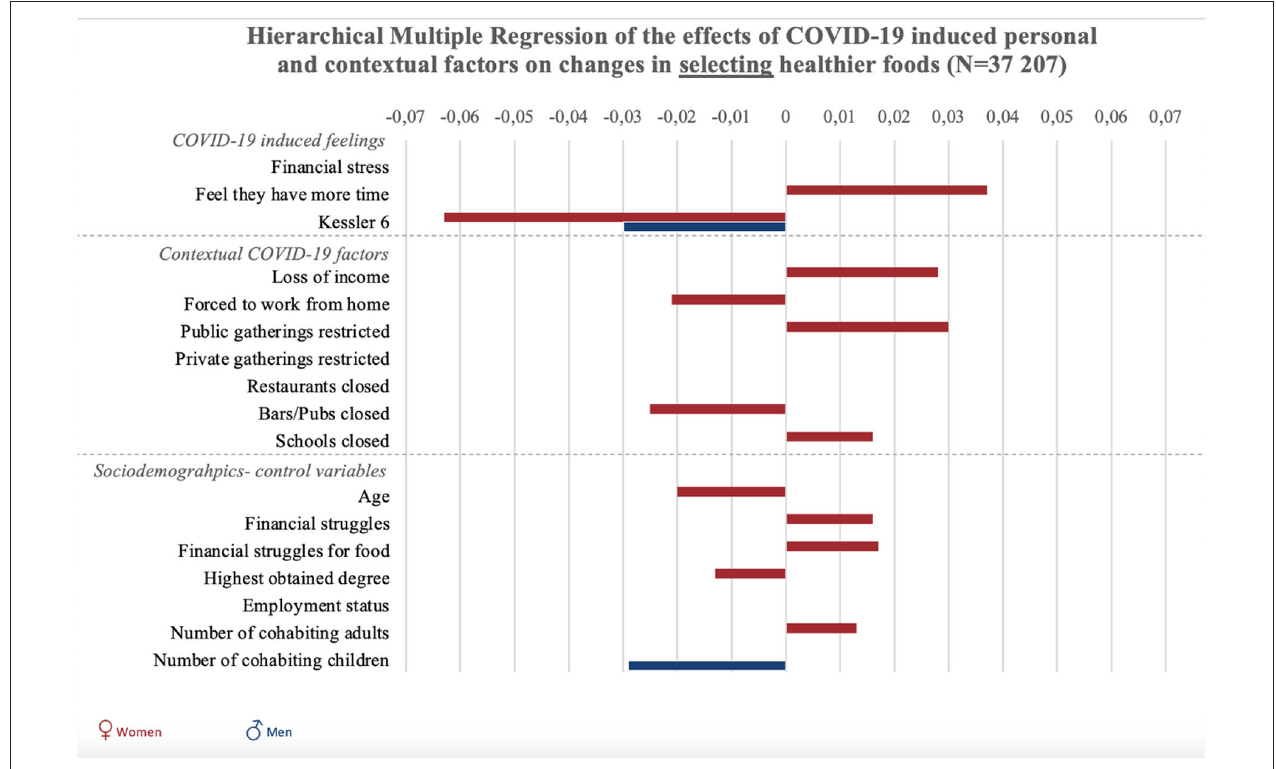
FIGURE 2 | Graphic summary of the significant relations between personal, contextual and sociodemographic variables and changes in selecting healthier foods during COVID-19. We report beta-values only for significant relations in models 2 for selecting healthier foods. Bars to the right indicate improvement in food selection, bars to the left indicate decreases selecting healthy